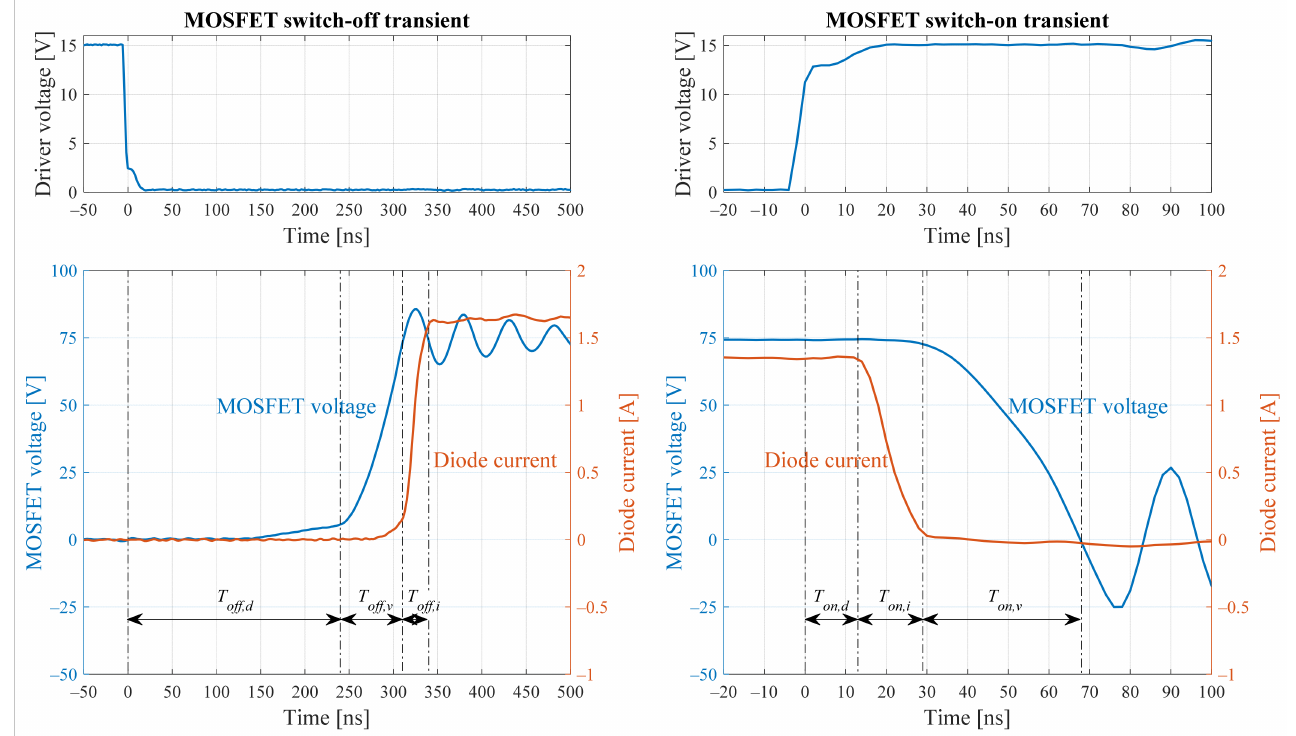
duty cycles and similar delay times have been observed.